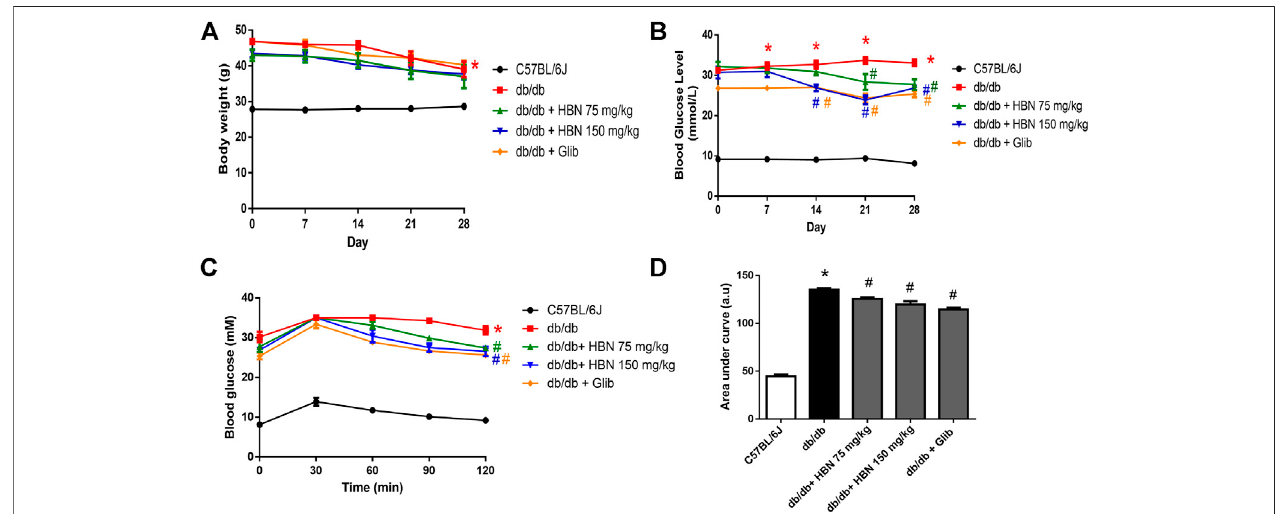
FIGURE2| EffectofHBNonbodyweight,fastingbloodglucoseandglucosetolerance. (A) Weeklybodyweightandfromday0today28, (B) weeklyfastingblood glucose (C) oralglucose tolerance test (OGTT) and (D) area under the curve for OGTTfollowing treatment with HBN (75 and 150 mg/kg) and glibenclamide (1 mg/kg) in db/db mice. Results are means ± SEM of six experiments. * p < 0.05 compared to C57BL/6J mice, # p < 0.05 compared to db/db mice.